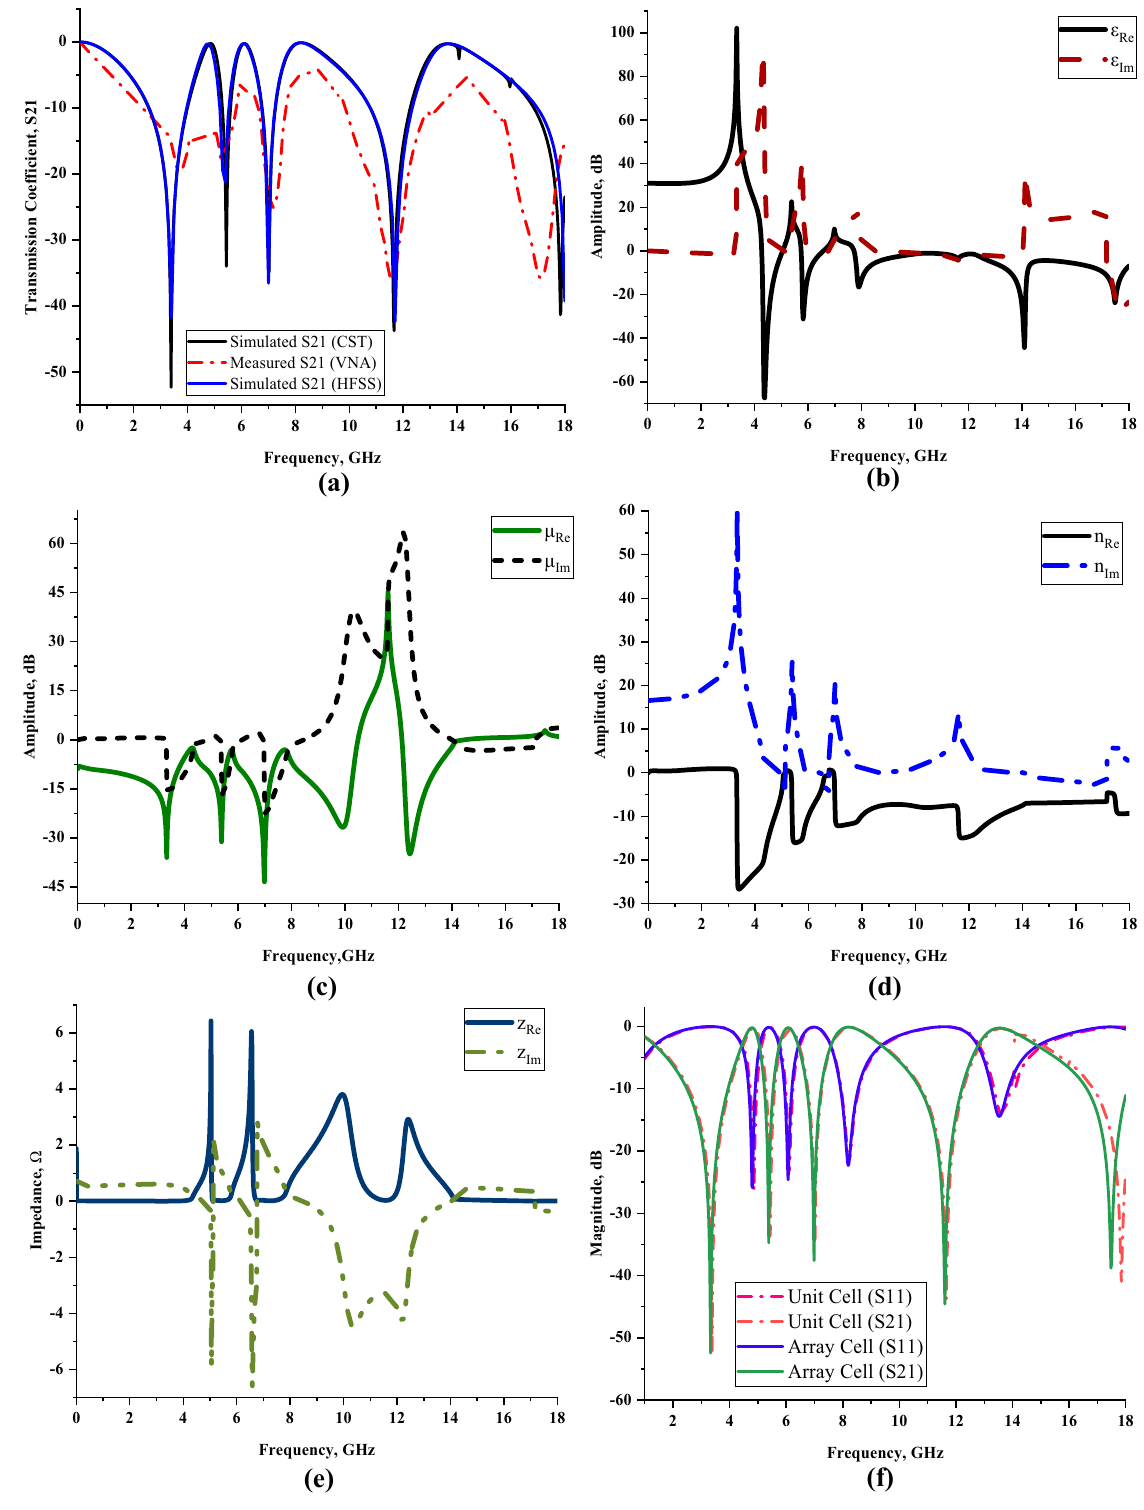
Figure 3. Scattering and effective medium parameters of the proposed SQM design: ( a ) Transmission coefficient (unit cell) of CST, VNA and HFSS, ( b ) permittivity, ( c ) permeability, ( d ) refractive index, ( e ) impedance value; ( f ) comparison of numerically simulated unit and array cells (S11 and